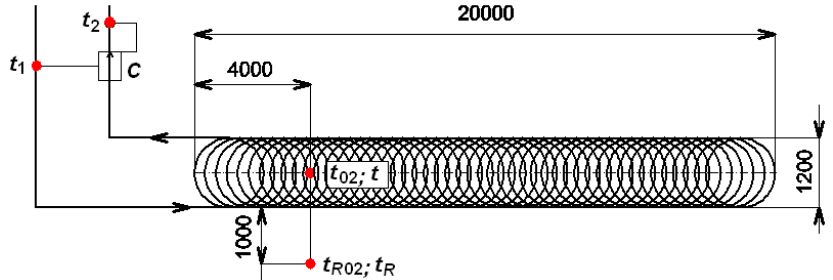
Figure 1. Plan of slinky-type heat exchanger and location of temperature sensors (exchanger dimensions in